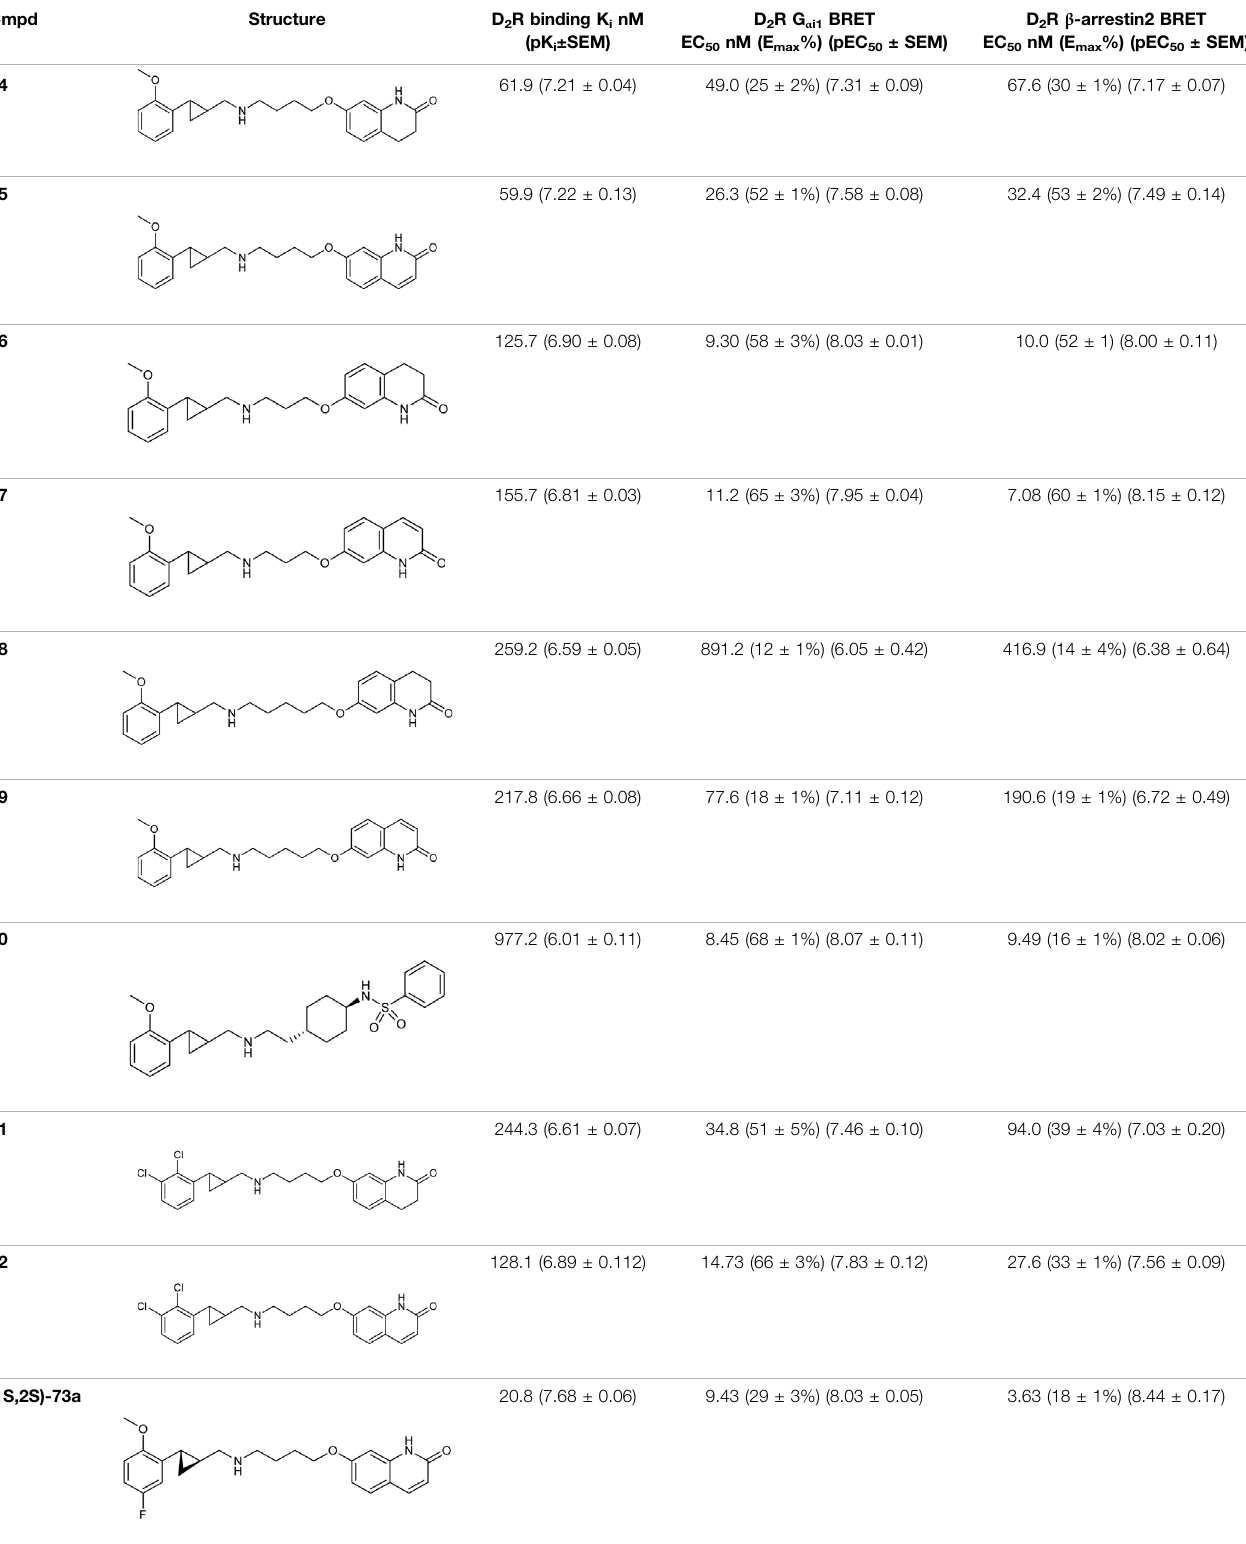
TABLE 5 | Pharmacological pro fi ling of compounds (D2R binding and functional activity) (Yan et al., 2021).